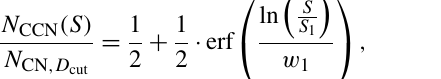
Figure 12. Predicted vs. measured CCN number concentrations us- ing the κ -Köhler model approach. This approach requires the fol- lowing time-resolved aerosol input data: (i) time-resolved aerosol size spectra spanning the CCN-relevant range (e.g., SMPS) and (ii) annual average κ values for the Aitken and accumulation size range ( κ Ait = 0.14 and κ Acc = 0.22). The color code shows the num- ber of data points falling into the pixel area, following Jurányi et al. (2011). The black line represents a bivariate regression fit of the data.